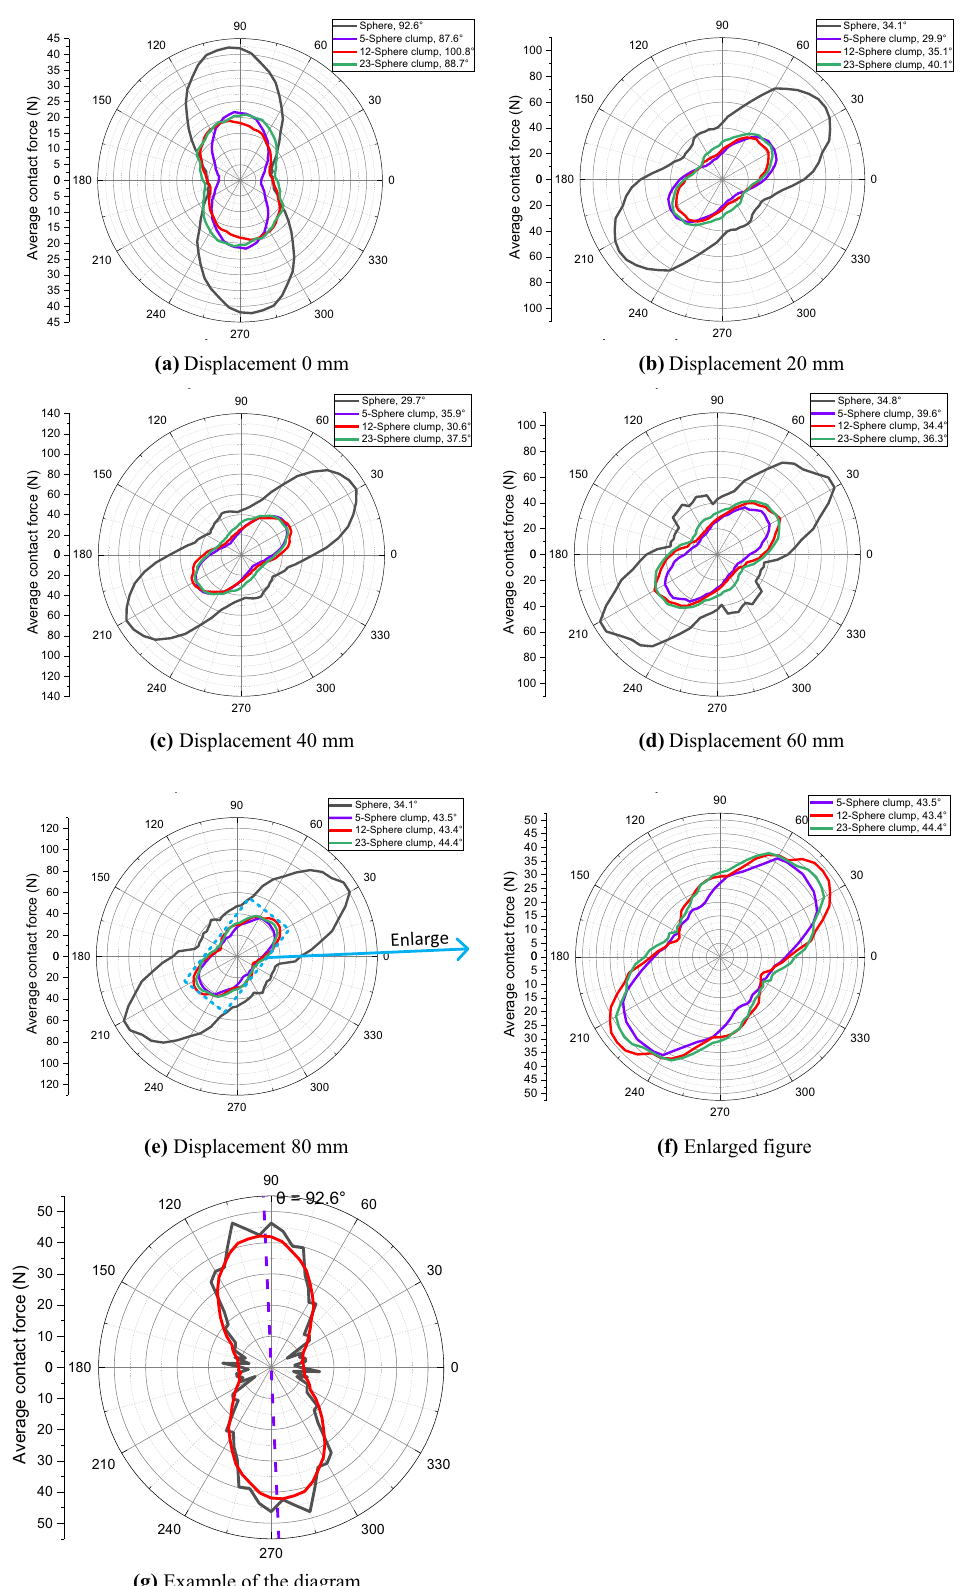
(g) Example of the diagram Fig. 8 Distributions of the particle normal contact forces under the normal stress 24